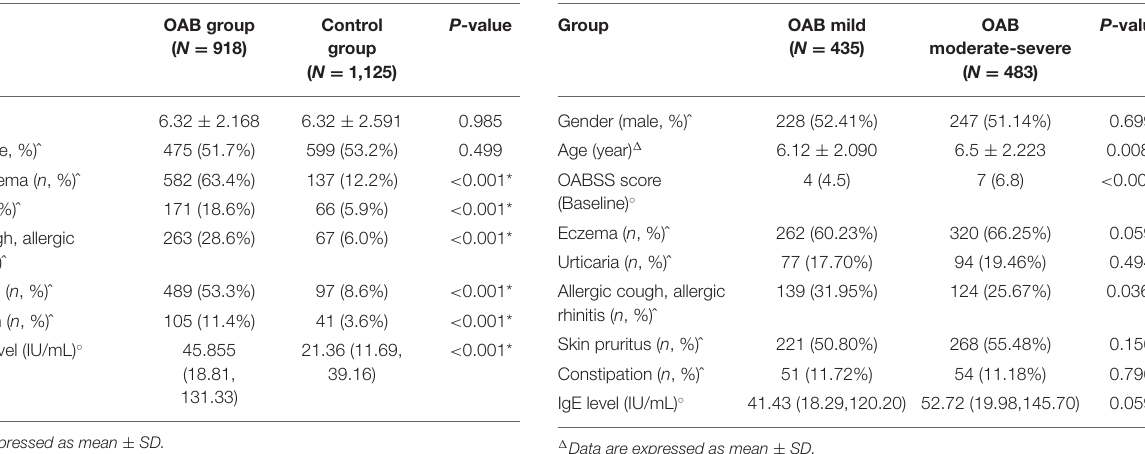
TABLE 1 | Univariate analysis of OAB risk factors.